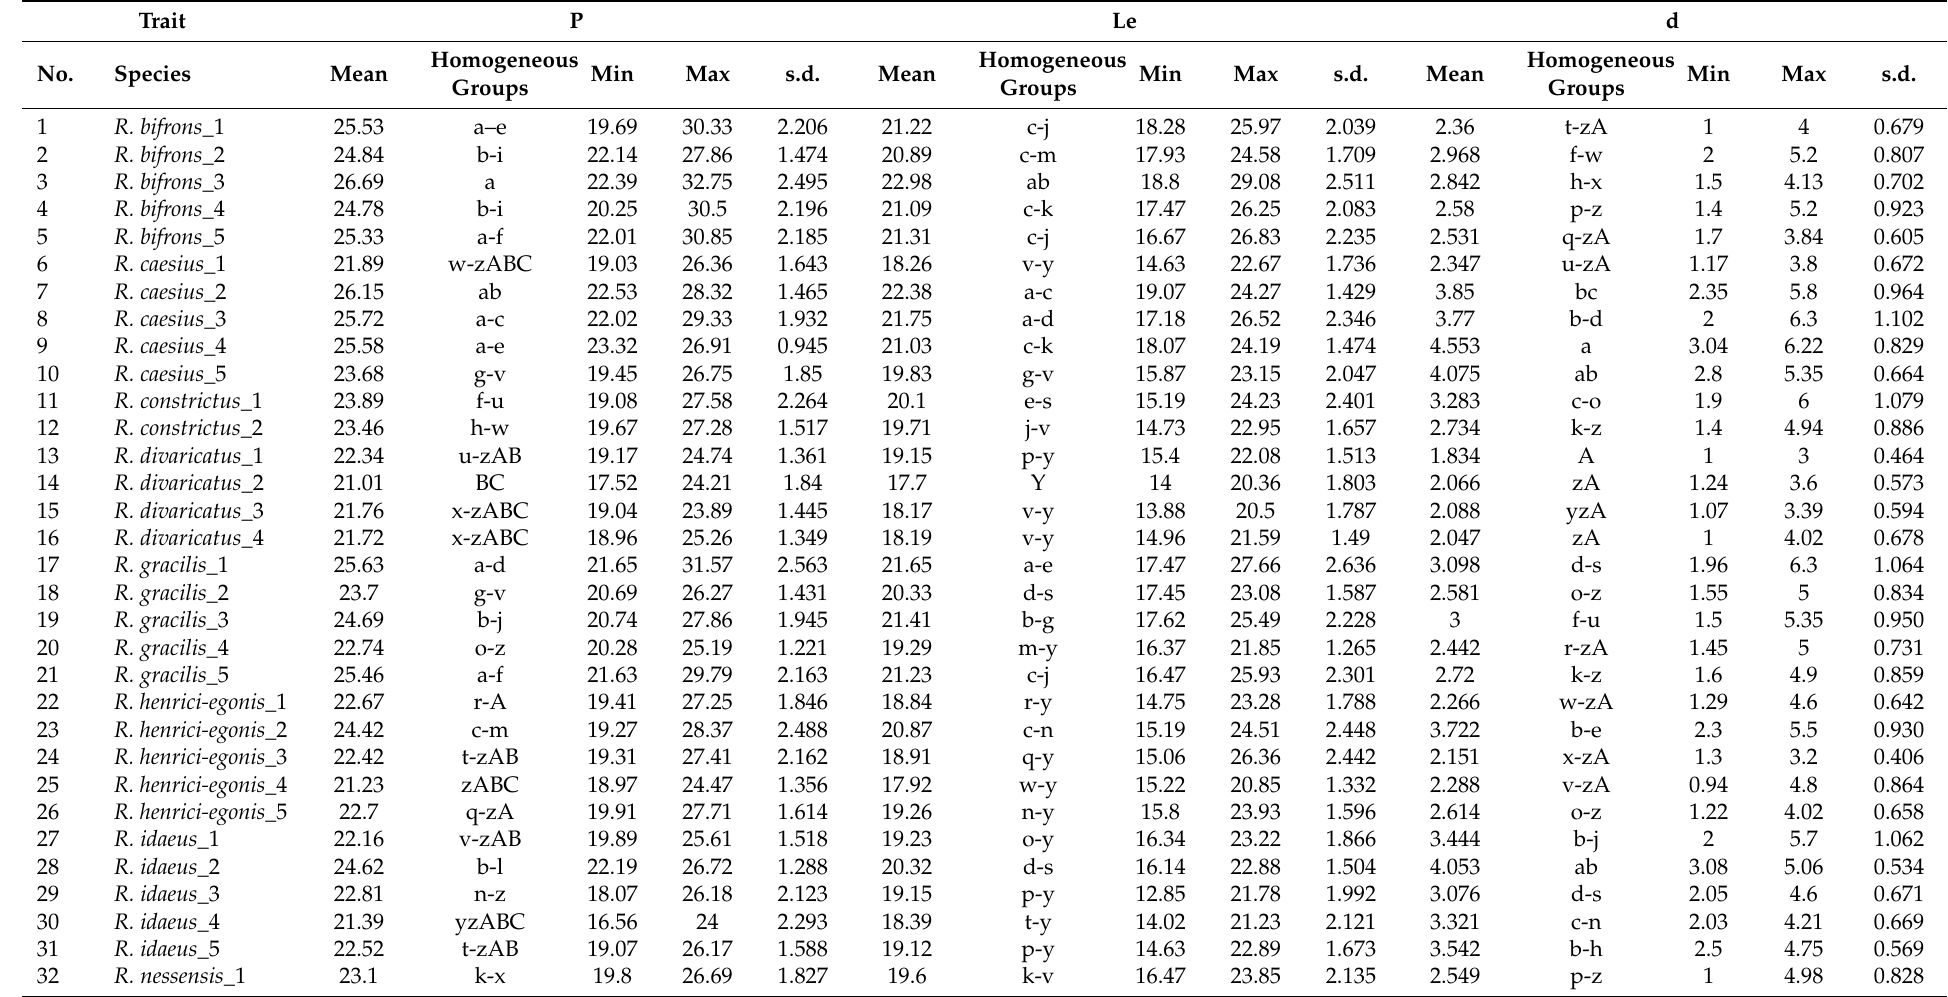
Table 3. Mean, minimal and maximal values as well as standard deviations (s.d.) for the length of the polar axis (P), length of ectoaperture (Le) and distance between apices of two ectocolpi